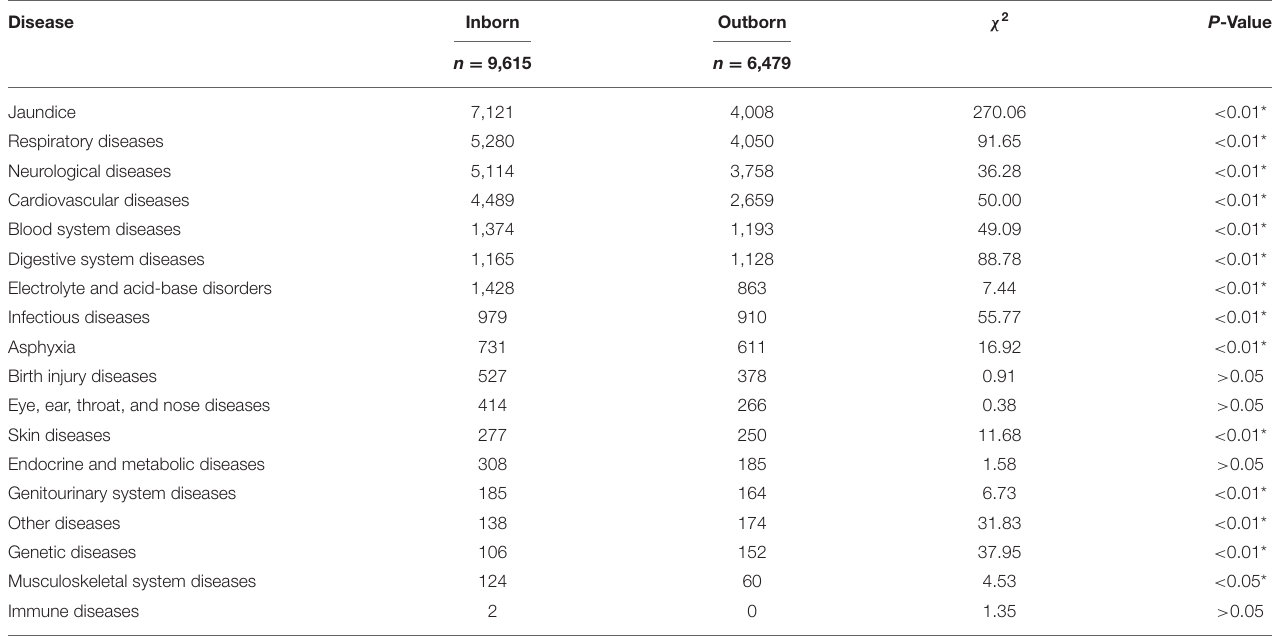
TABLE 11 | Prevalence of neonatal diseases in relation to patient source. Disease Inborn